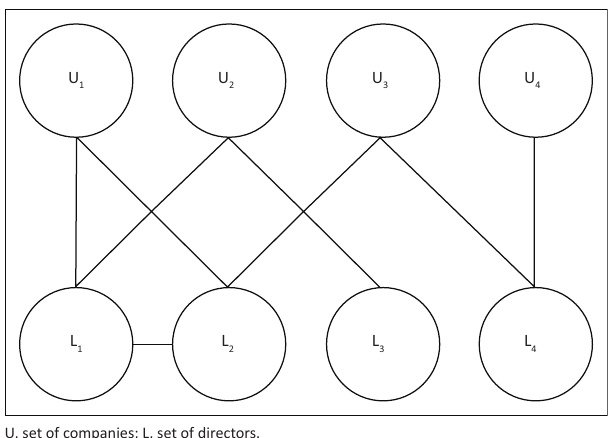
FIGURE 1: The projection of a bipartite to a single-mode